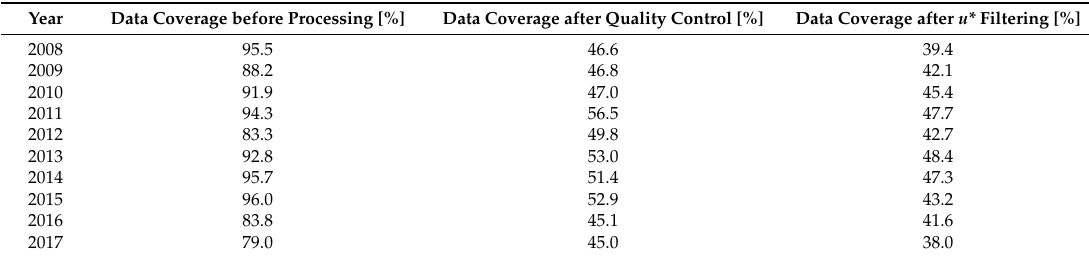
Figure A6. Evolution, from the year 2008 (age 36) until 2017 (age 45), of tree’s DBH distribution, by tree species, for stands around eddy covariance tower. Table A1. Percentage of half-hourly NEE files before processing, after quality control filtering procedures and after u* filtering procedure.